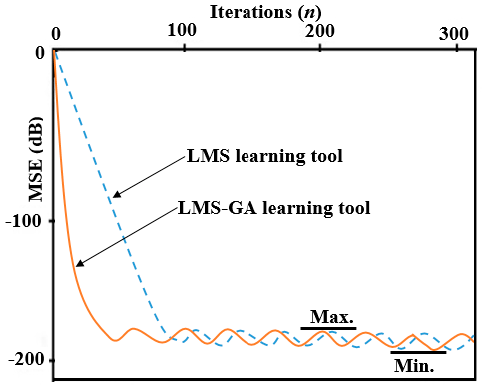
Figure 19. The convergence performance of the LMS-GA tool for adaptive IIR filter.